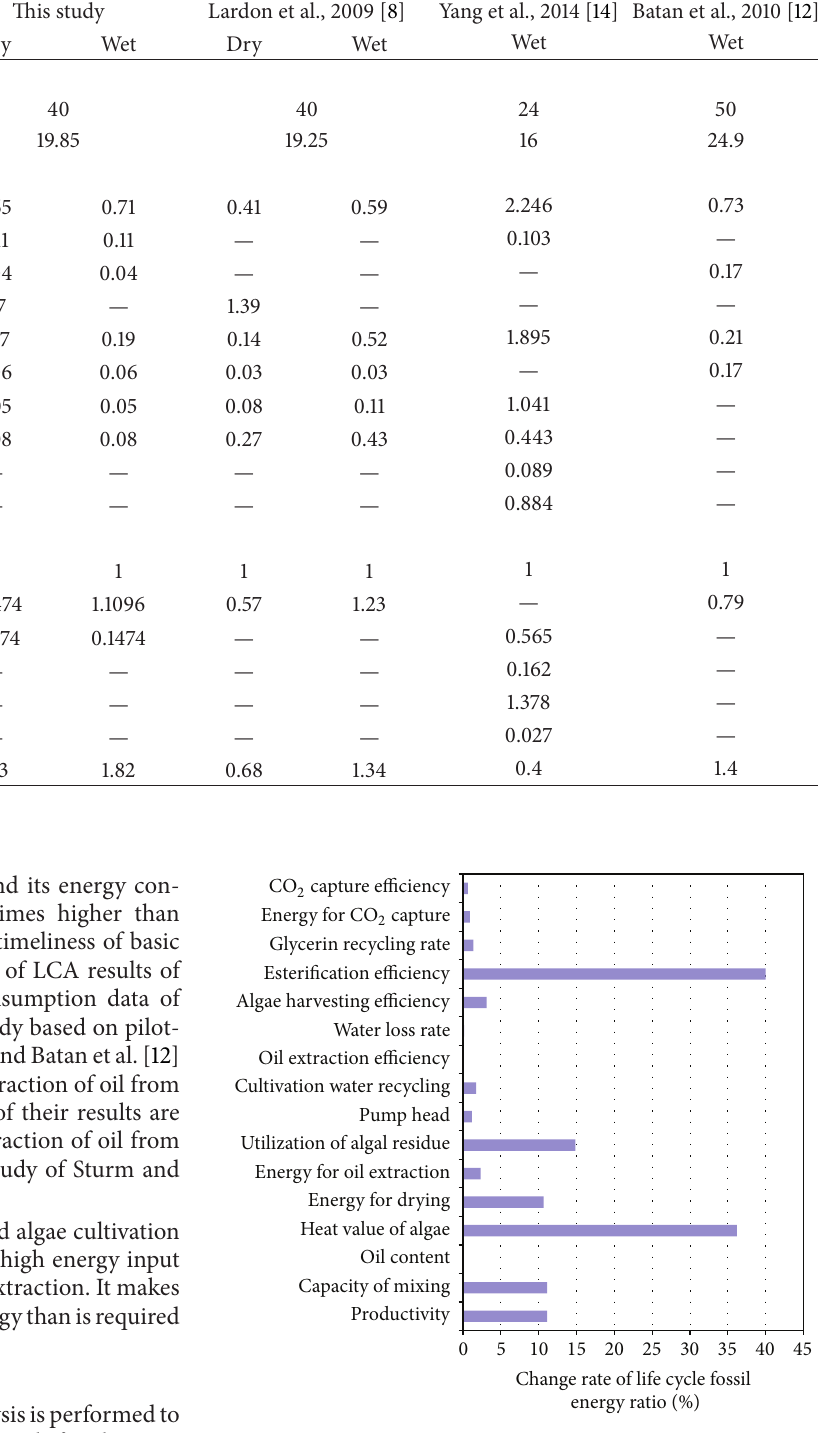
algae have been taken as the baseline scenario. The change rate of all uncertain parameters is